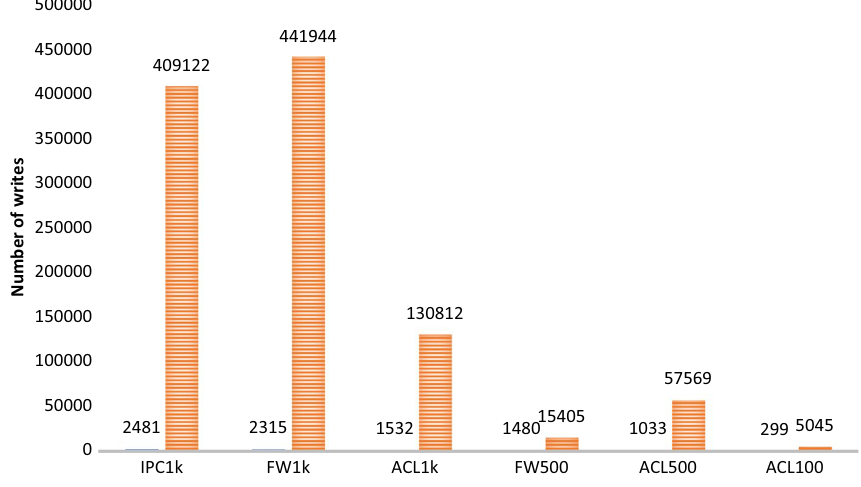
Fig. 13 Number of writes required for removing a